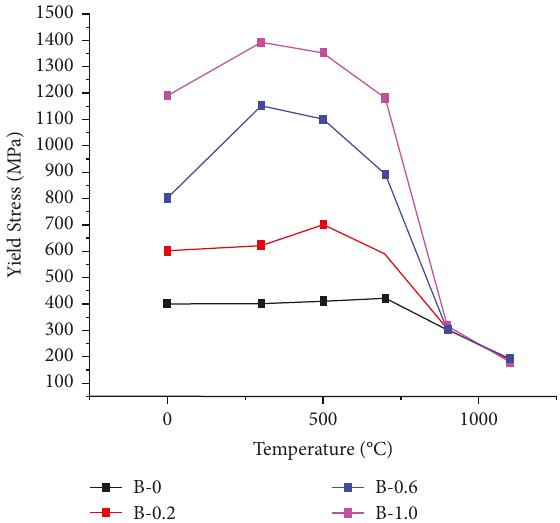
Figure 11: Requirement of yield stress on temperature for CuCoNiCrAl 0.5 Fe. HEA with different boron contents [27]. Figure 12: XRD pattern of the Al